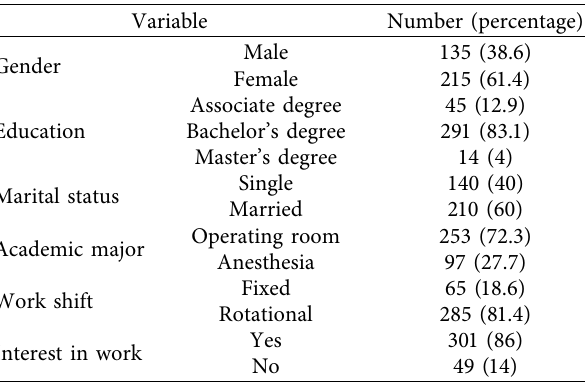
Table 1: The participants’ demographic characteristics.